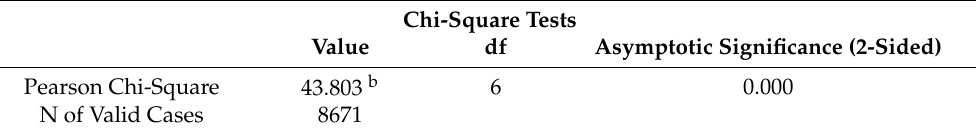
Table 9. Chi-square test (enterprise size vs. change in the ROA 2020 profitability indicator). Source: own research .